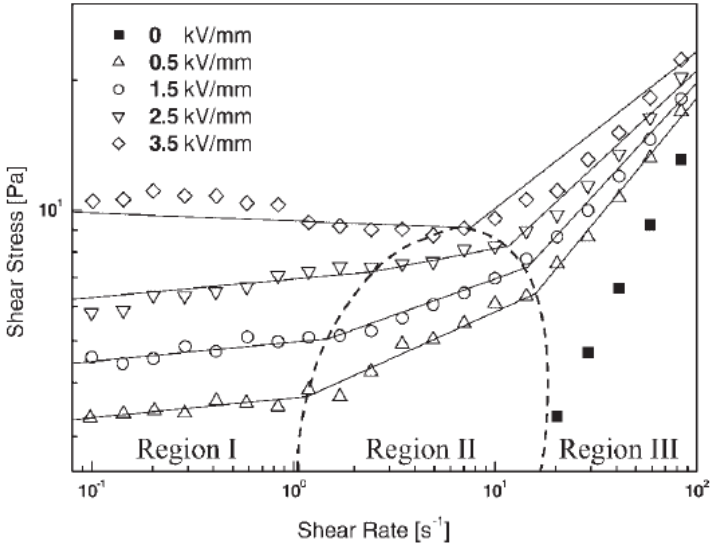
Figure 10. Shear stress vs. shear rate for MWNT/PMMA particle based ER fluid (reprinted with permission from [34], Copyright 2005